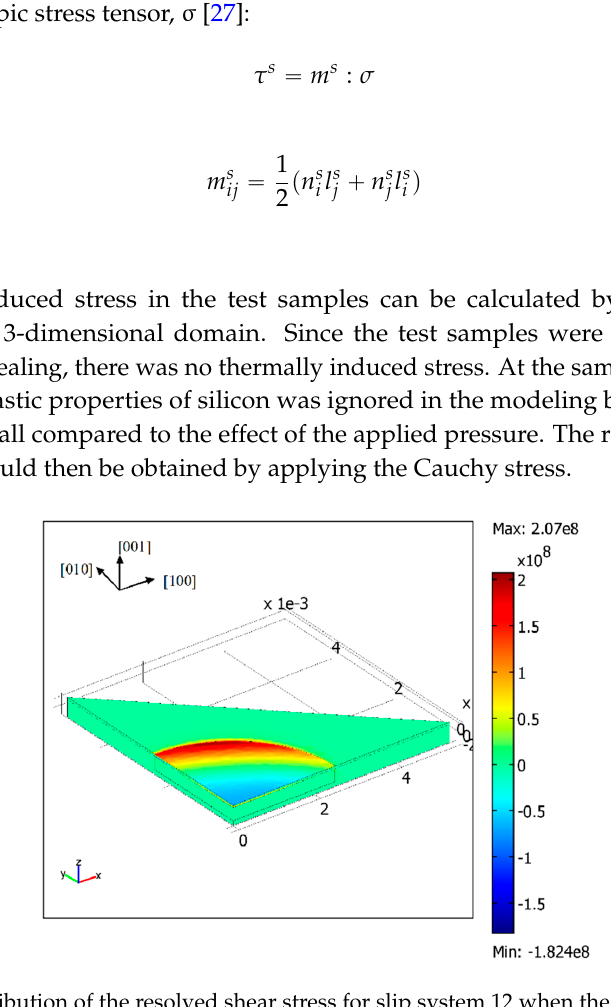
Figure 4. The distribution of the resolved shear stress for slip system 12 when the diaphragm radius is 2.5 mm (Pa).